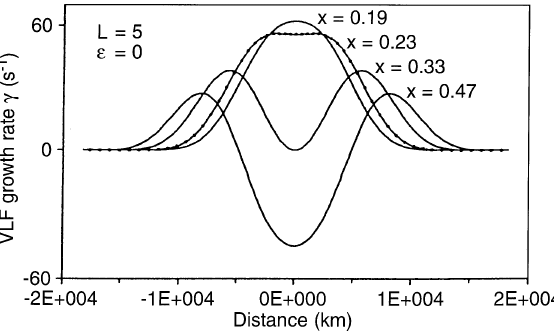
Fig. 5. Unperturbed growth-rate behaviour along the magnetic field line for several normalized VLF frequencies x . Computations are made for L " 5 and for magnetosphere plasma parameters D " 1.5, (cid:97)(cid:98) (cid:69) " 1, (cid:97) " 10; x " 0.19 corresponds to the maximum equatorial growth rate, x " 0.23 is the frequency of the maximum path-integrated growth rate, x " 0.33 is the upper cut-off frequency in the equatorial plane (no wave generation in the equatorial plane) and x " 0.47 is the frequency of zero path-integrated growth